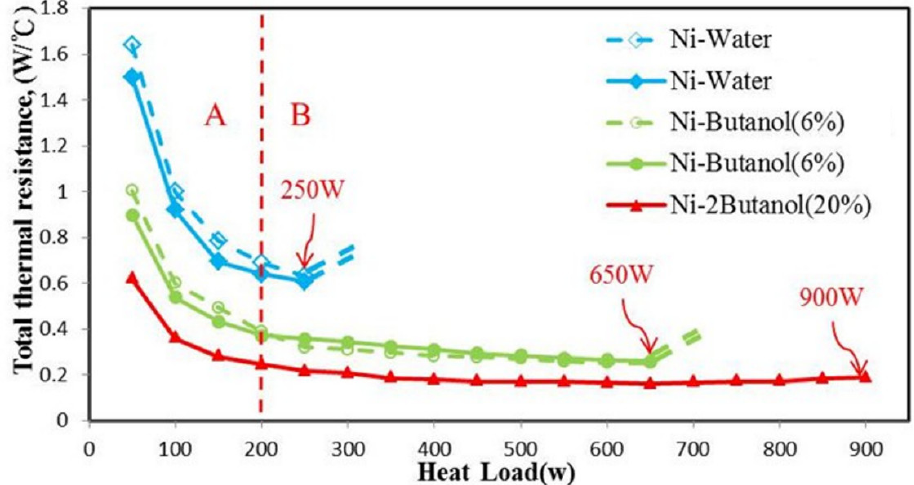
Figure 9. Thermal resistance as a function of heat load for three different test samples [10].